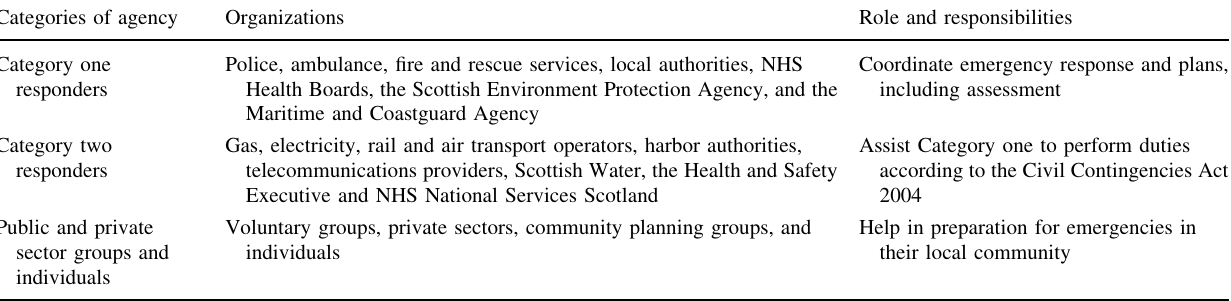
Table 1 The nature of Scotland’s multi-stakeholder resilience community. Source : Adapted from the Preparing Scotland report (Scottish Government 2019a) Categories of agency